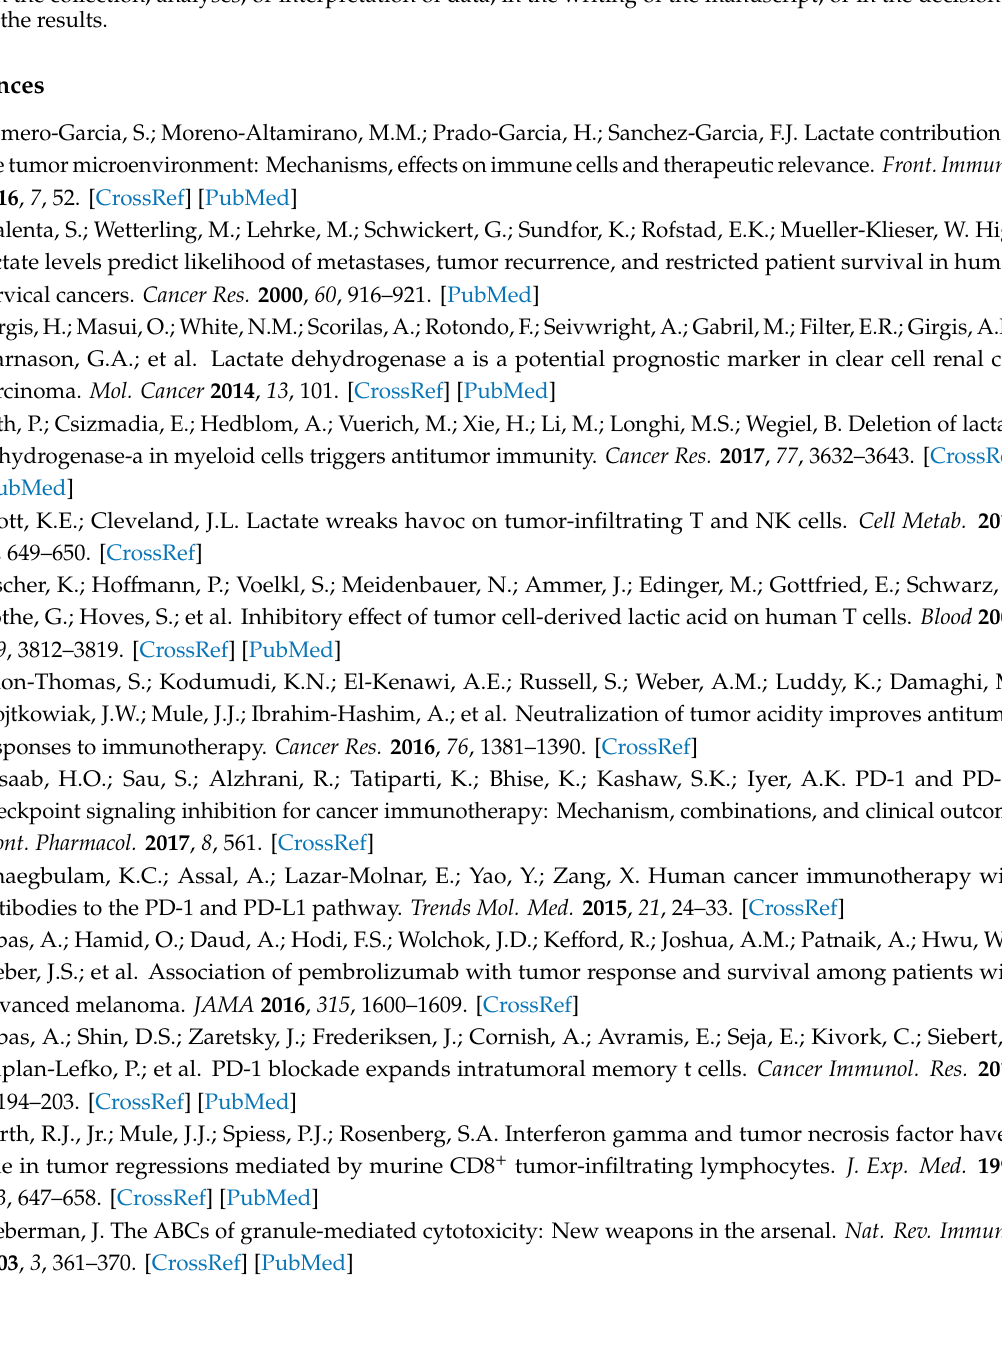
Figure S1: LDH-A Western Blot, Figure S2: Intra-tumor staining, Figure S3: Intra-tumor CD8 + infiltration, Figure S4: TC17